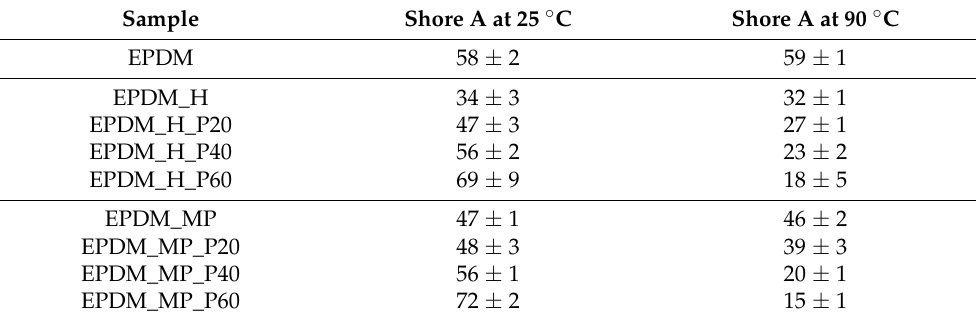
Table 10. Shore A